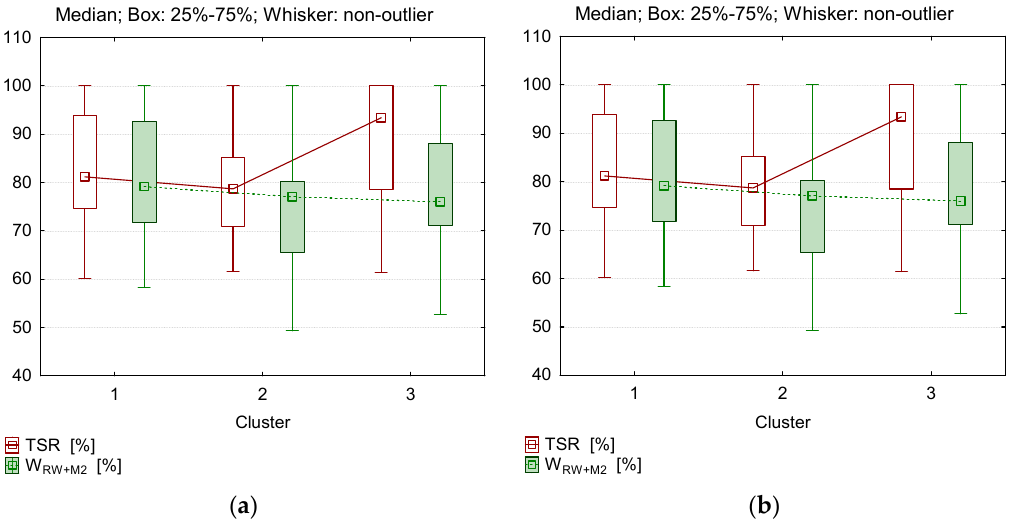
Figure 5. Grouping by: ( a ) moisture resistance (TSR and W RW+2M ); ( b ) indirect tensile strength at 25 °C (ITS).